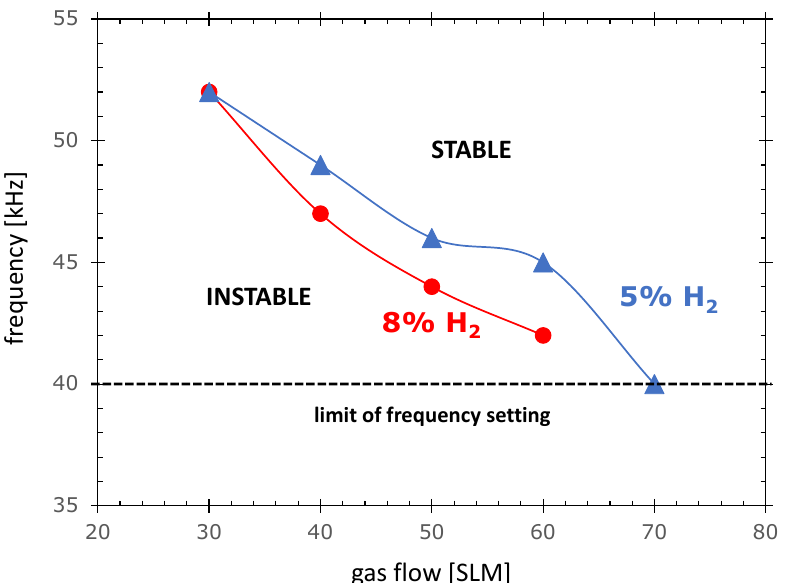
Figure 5. The zones of stability and instability of the PAA-PJ with dependence on HV pulse frequency and gas flow for two hydrogen percentages in the N 2 -H 2 -gas